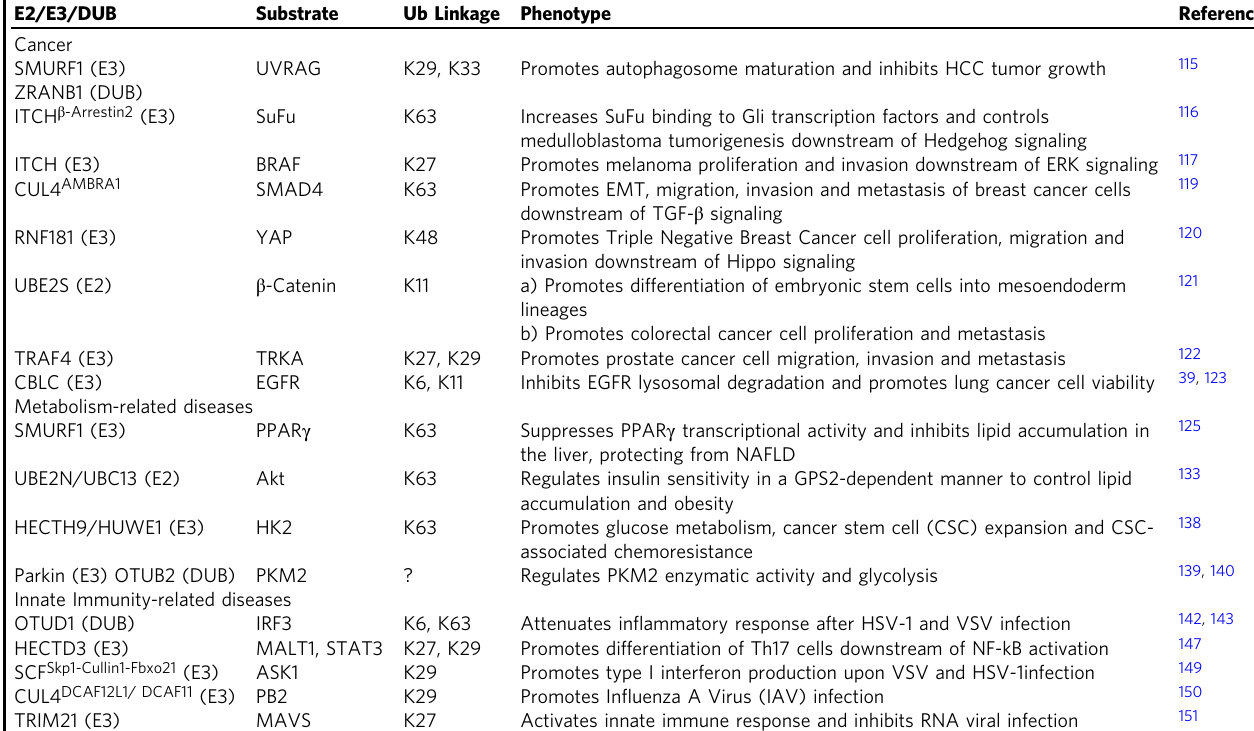
Table 2 List of non-proteolytic ubiquitylation events described in different disease-mediating